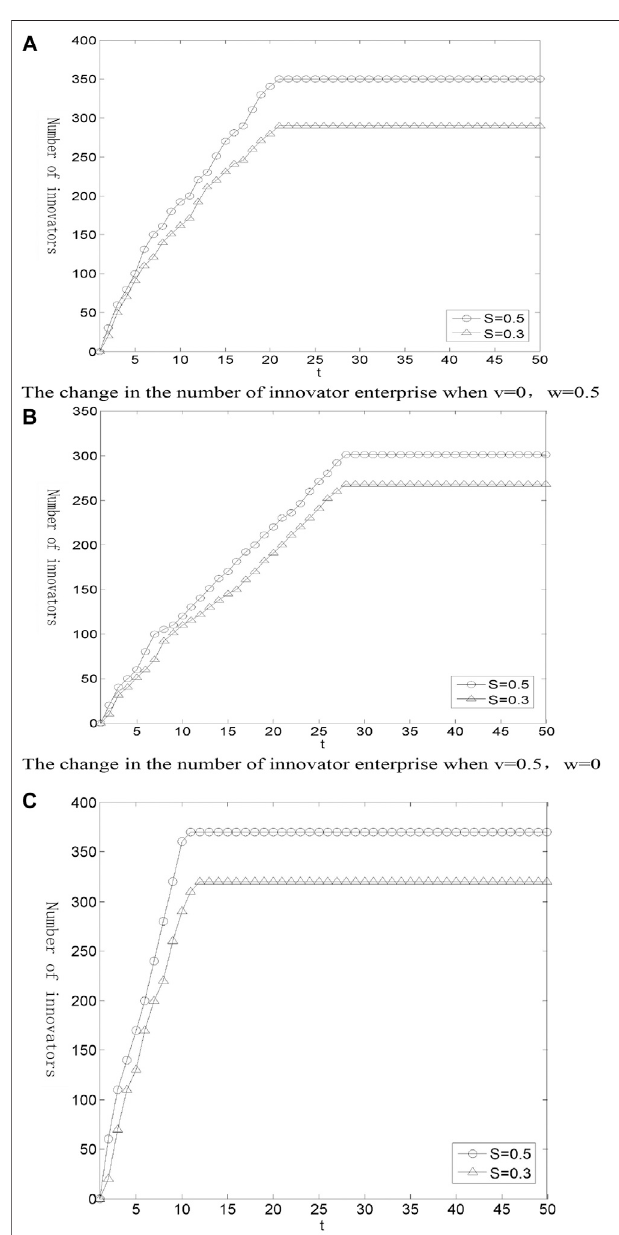
FIGURE 1 | The in fl uence of the innovator ’ s expected utility S on the innovator enterprise. (A) The change in the number of innovator enterprise when v (cid:2) 0, w (cid:2) 0.5. (B) The change in the number of innovator enterprise when v (cid:2) 0.5, w (cid:2) 0. (C) The change in the number of innovator enterprise when v (cid:2) 0.5, w (cid:2)